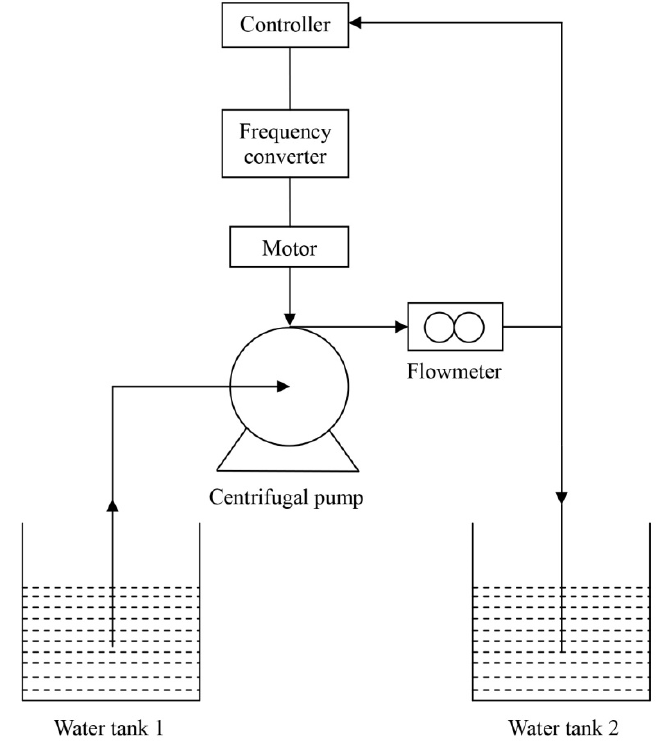
Figure 9. Test platform of centrifugal pump flow adaptive control system.